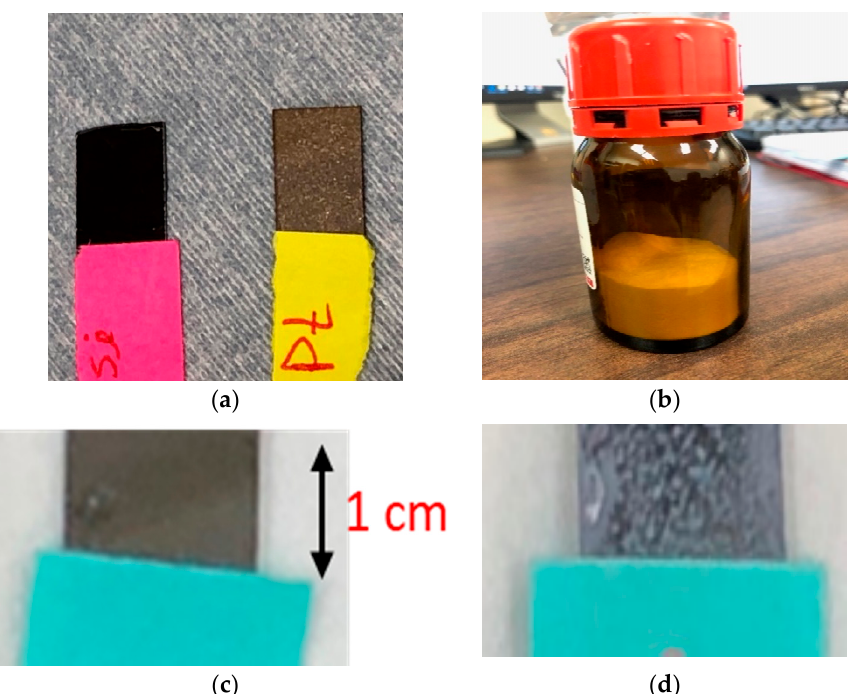
Figure 2. ( a ) Cleaned silicon sample and platinum sample (electrode). ( b ) ZnO nanopowder as- purchased from Sigma-Aldrich (catalog number 677450). ( c ) Substrate treated by warm piranha solution and ( d ) Silicon substrate treated by APTES solution prepared for ZnO electrophoretic deposition.